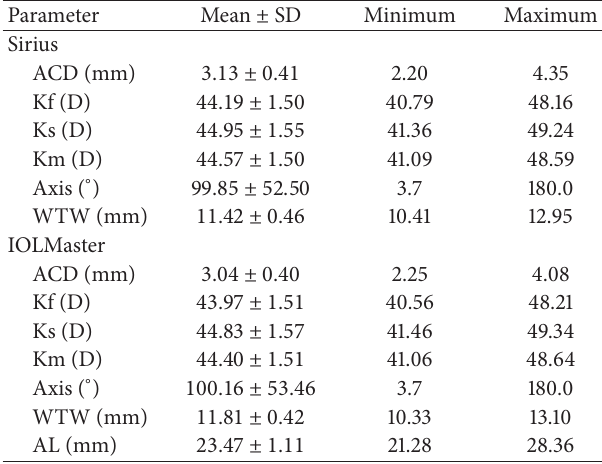
Table 1: Descriptive statistics of ocular measurements by Sirius Scheimpflug/Placido photography-based topography system and IOLMaster partial coherence